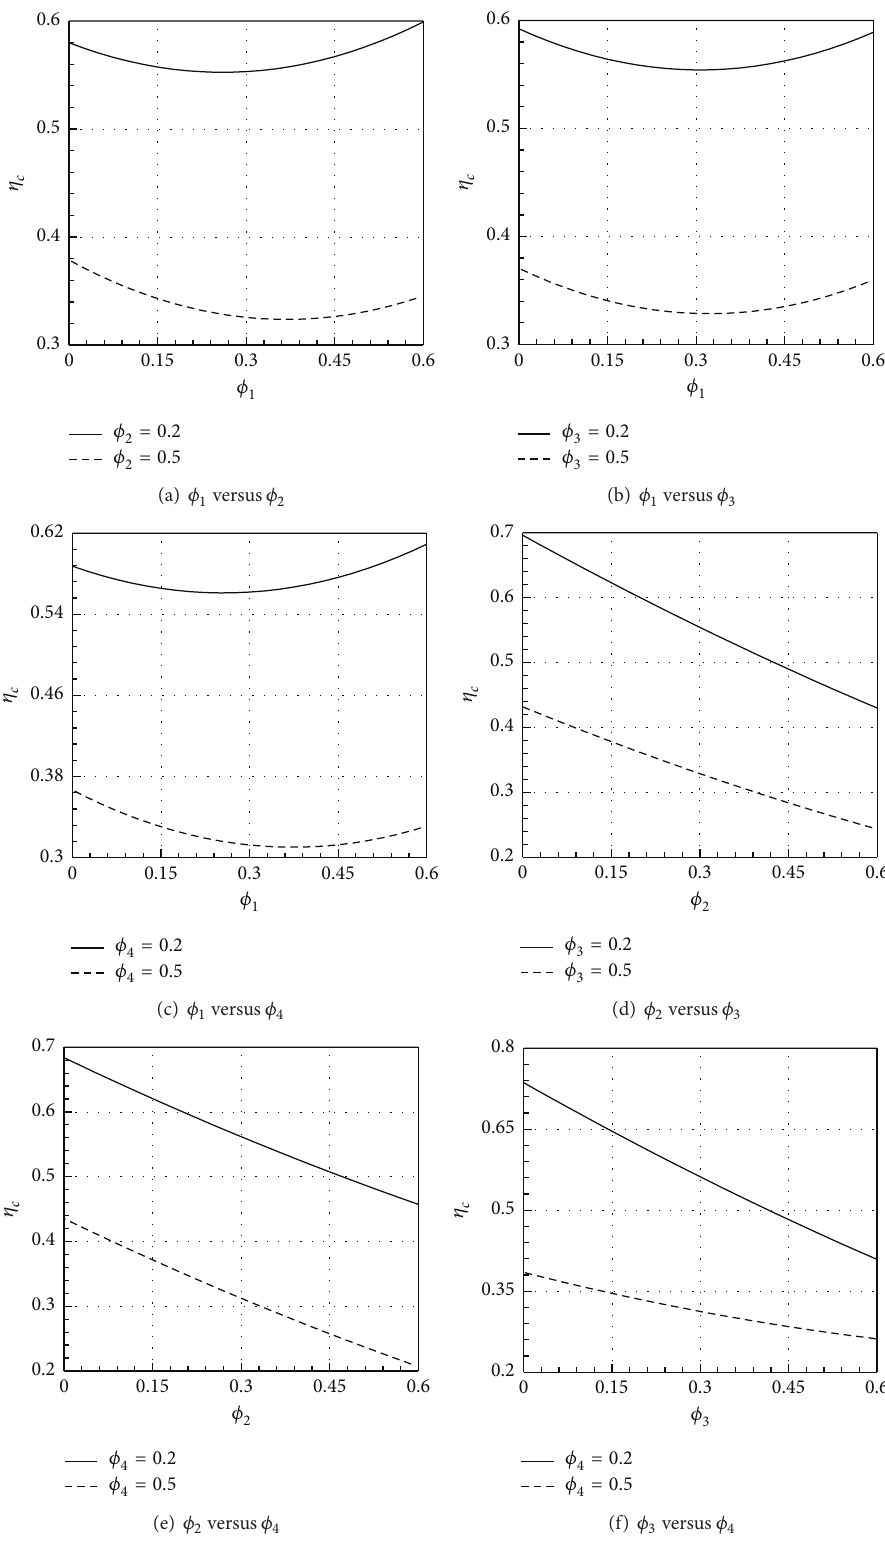
Figure 9: Interaction effects of the design variables on the combustion